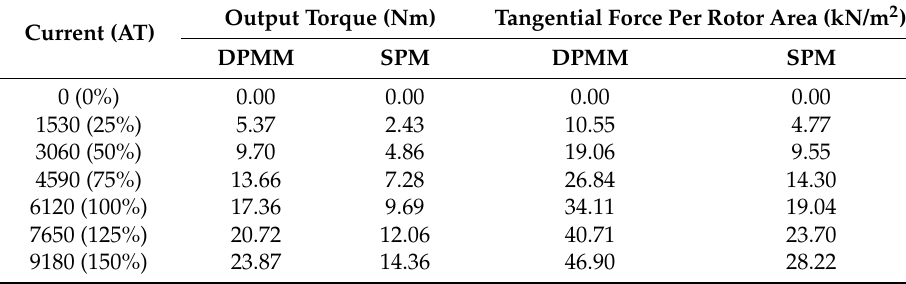
Figure 4. Tangential force density comparison for different air gap lengths. It is a controversy that the increase in the force density produced by the DPMM machine comes from a higher volume of the PMs, which is the most expensive material when fabricating a machine. However, the effectiveness should be compared in terms of the tangential force per volume of the PMs. The total volume of the PMs for the SPM and DPMM machine is estimated at 547.2 × 10 − 6 m 3 and 742.2 × 10 − 6 m 3 , respectively. Under rated conditions, tangential force density based on the volume of PMs from DPMM and SPM machines is 24.0 kN/m 3 and 17.7 kN/m 3 , respectively. This